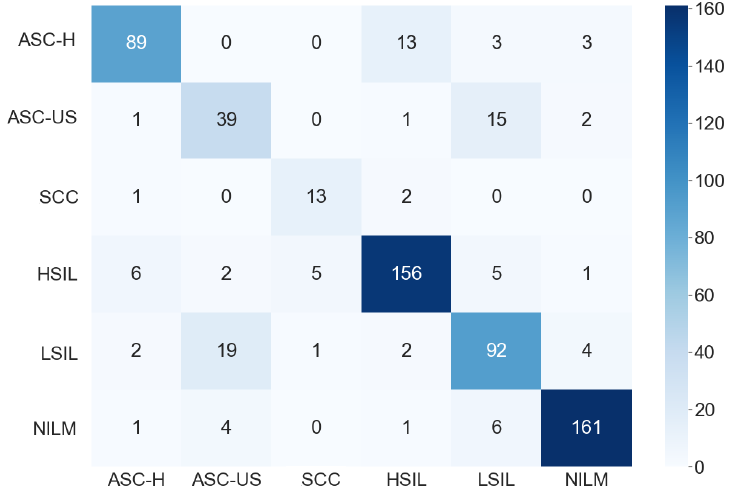
Figure 7. Confusion matrix for the six-class classification.